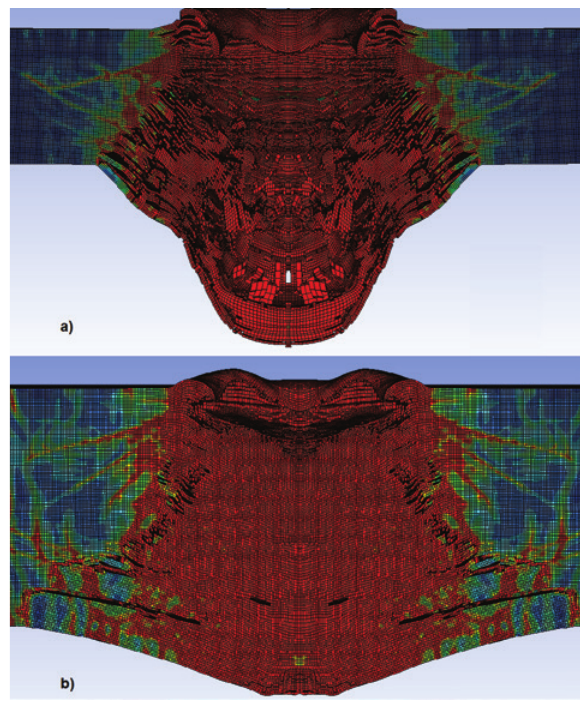
Nível de dano provocado numa placa de concreto pela detonação do explosivo com geometria otimizada, 3º simulação (a); 5º simulação